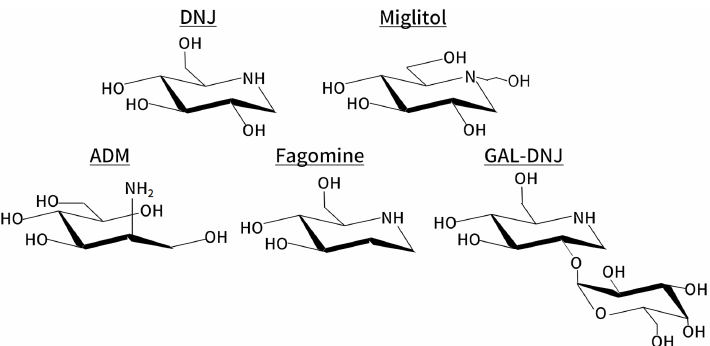
Fig 1. Chemical structures of aza-sugars. Chemical structures of 1-Deoxynojirimycin (DNJ), miglitol, 2-amino- 2-deoxy-D-mannitol (ADM), fagomine, and 2-O- α -D-galactopyranosyl-deoxynojirimycin